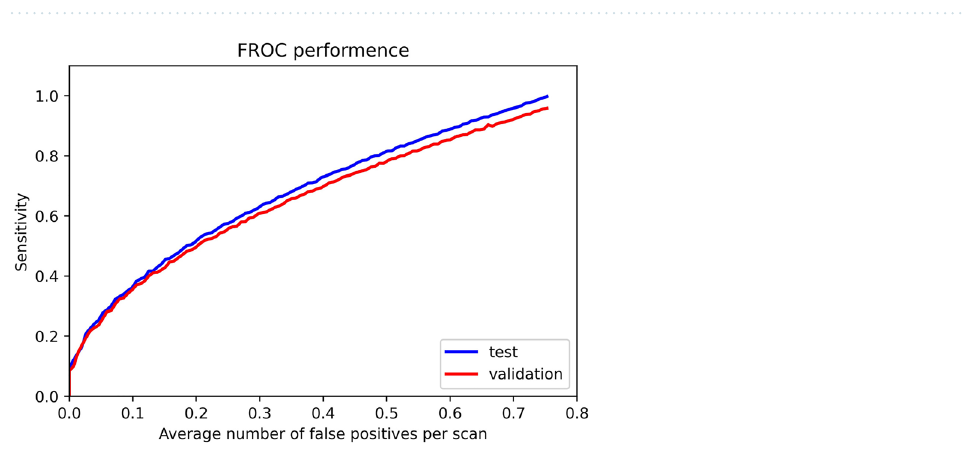
Figure 3. Rib 3D view. The red rectangular box was the selected fracture lesion, and the green parts were the other suspected fracture lesions detected by our Rib Fracture Detection System.